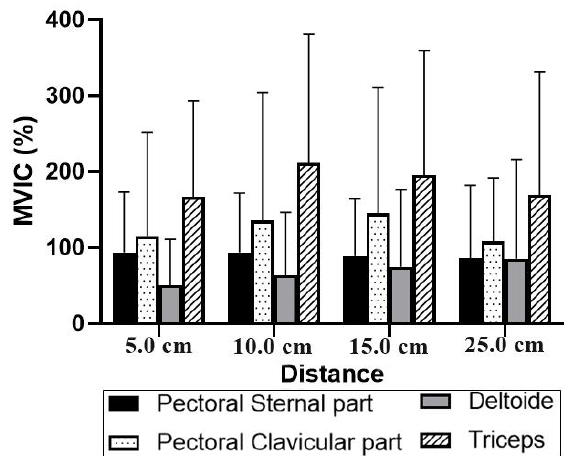
Figure 5. Electromyography of the pectoral, sternal and clavicular parts, deltoid and triceps at different distances from the chest. Legend: MVCI: maximal voluntary isometric contraction (%).